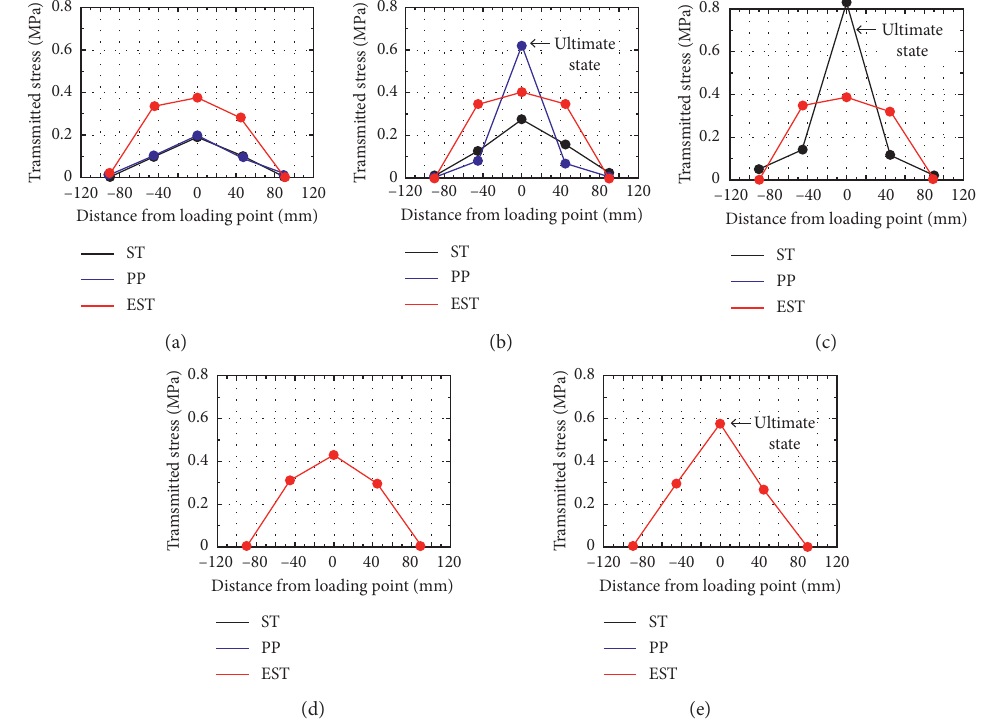
Figure 14: Transmitted impact stress distribution at the time of the maximum penetration with the core slab. (a) H � 200mm.